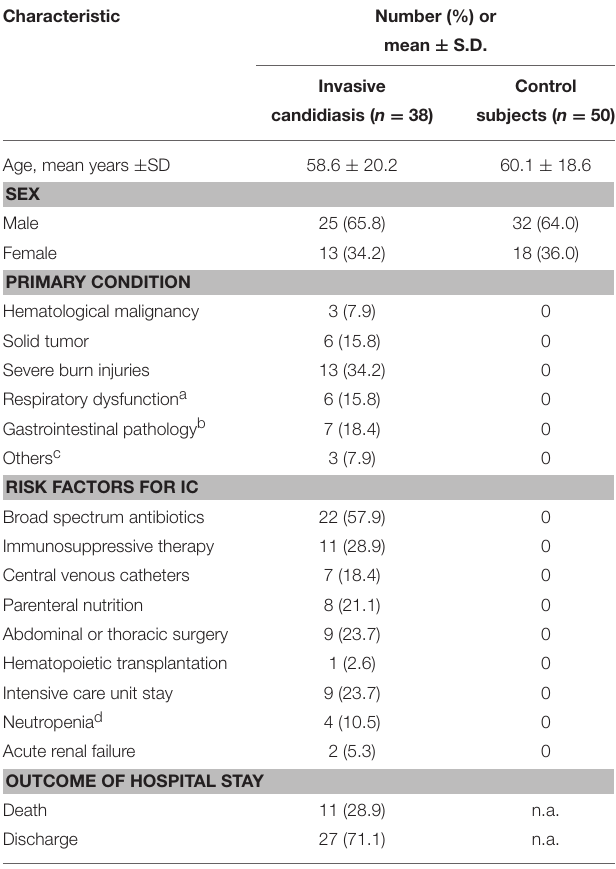
TABLE 1 | Base-line characteristics of the 88 subjects included in the study.